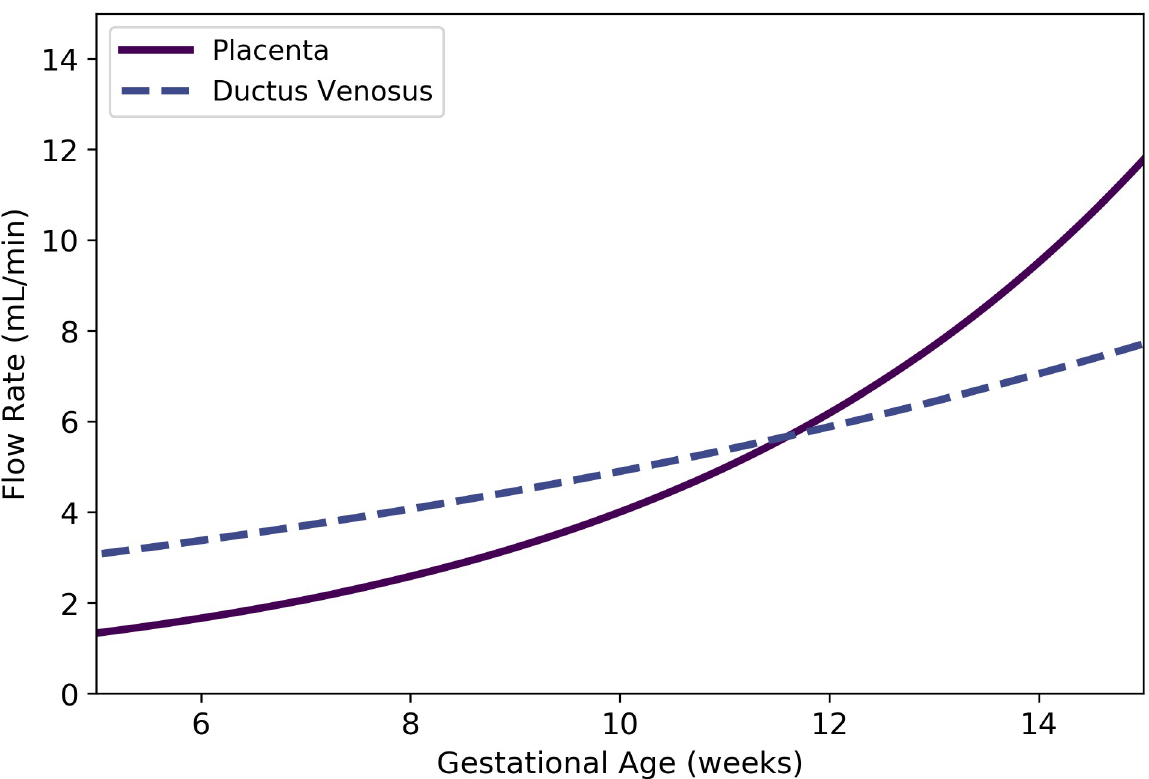
Fig 27. Comparison of flow rates through the placenta and through the ductus venosus vs. gestational age (cf. Eqs 50 and 51). Because blood flow through the ductus venosus should always be less than blood flow through the placenta, these models should not be used prior to gestational age 12